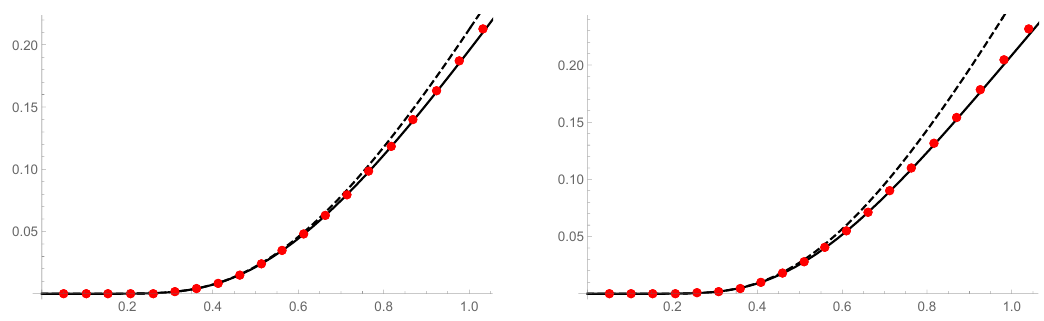
Figure 6 . In these figures we compare the difference between the normalized energy density and the real part of the Borel resummation of the perturbative series, against the theoretical predictions (3.76) for the Gross-Neveu model with N = 7 (left) and N = 8 (right). The x -axis is the value of α . The dots (red) are the numerical calculations of the l.h.s. of (3.76), using a discretisation of 50 points in the integral equation and 120 coefficients in the perturbative series, evaluated at B = 20 /k for k = 1 , . . . , 20 . The dashed line (black) is the contribution in (3.76) coming from the leading IR singularity, while the full line (black) includes also the first two terms of the new, unconventional renormalon